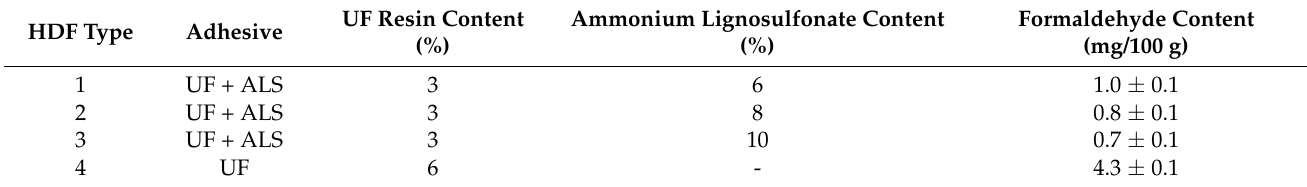
Table 2. Formaldehyde content of HDF panels according to EN ISO 12460-5.